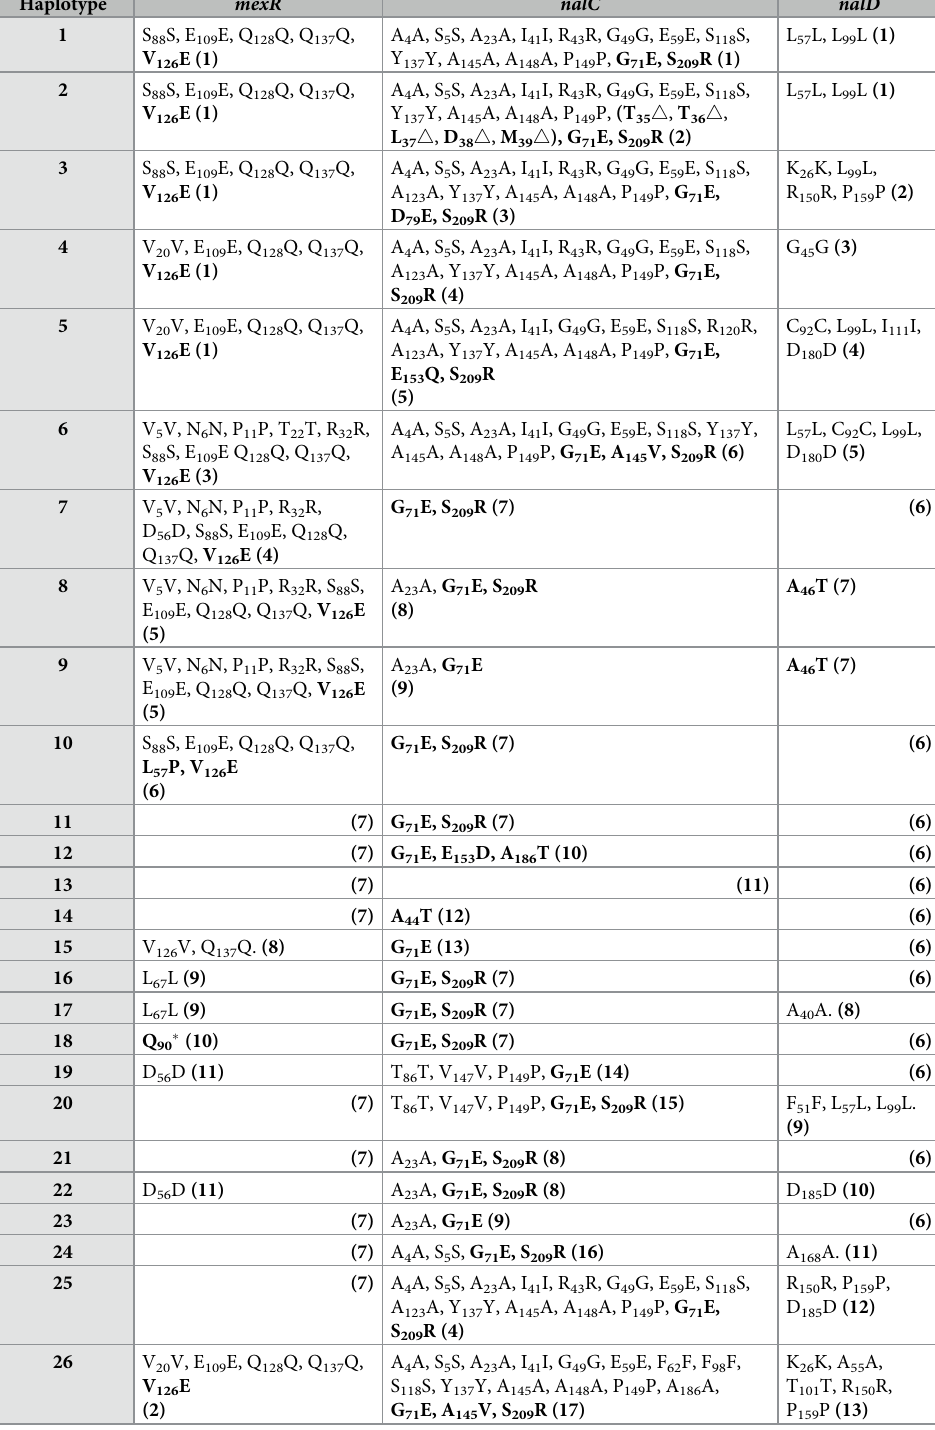
Table 3. Genetic variations (haplotypes) identified in the mexR , nalC and nalD repressor genes in P . aeruginosa